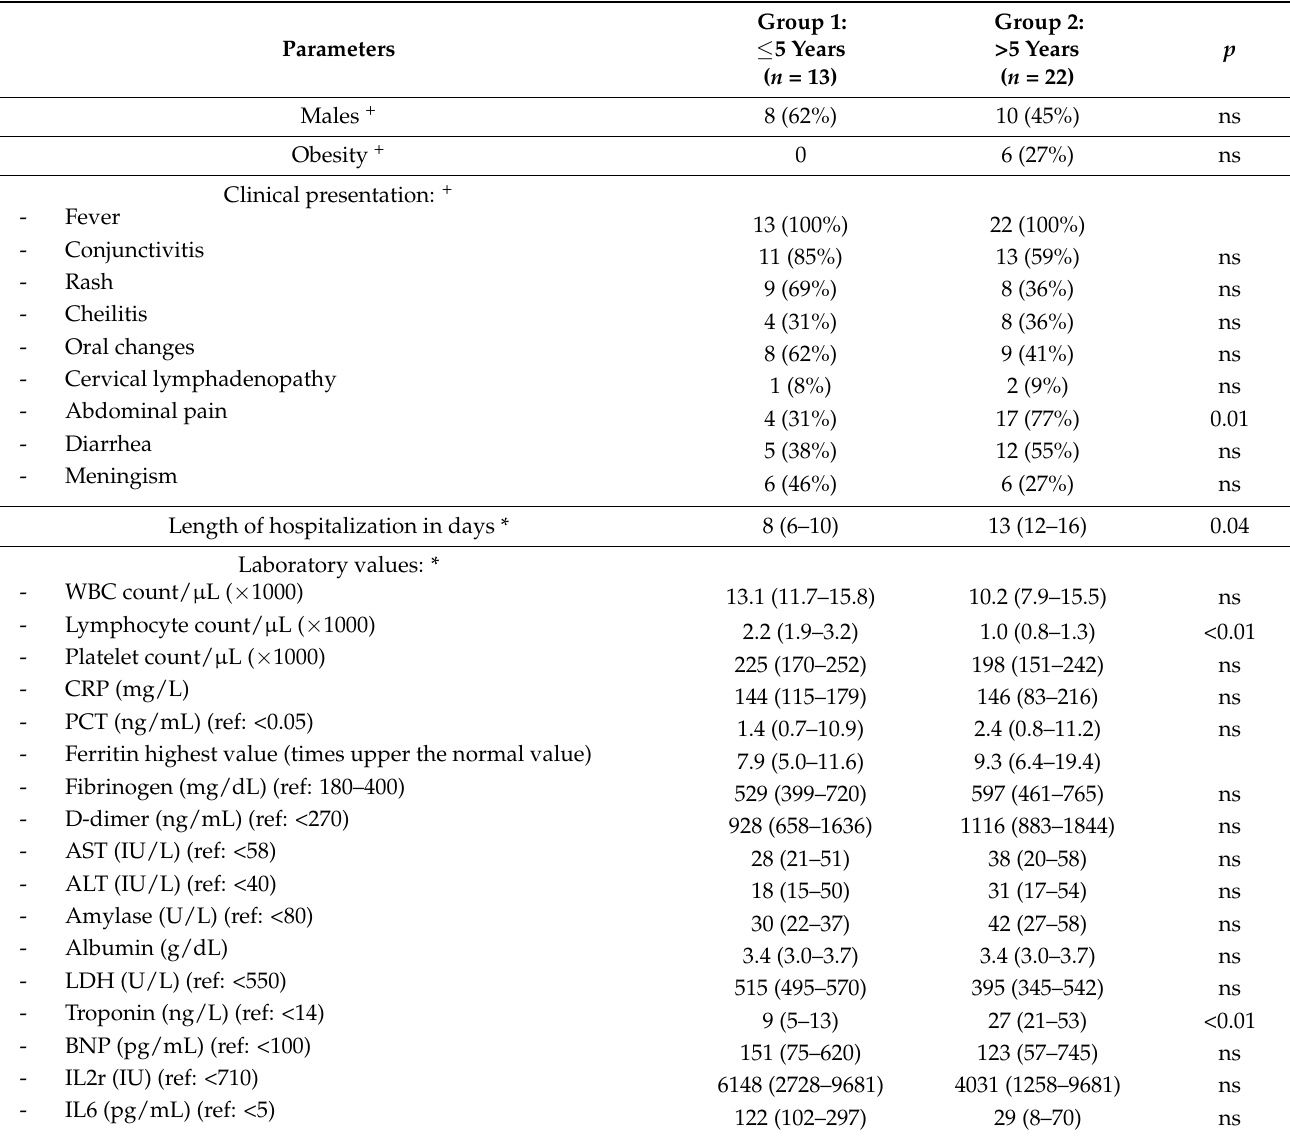
Table 2. Demographic, clinical, laboratory, and imaging characteristics and treatment in patients with MIS-C divided in two age